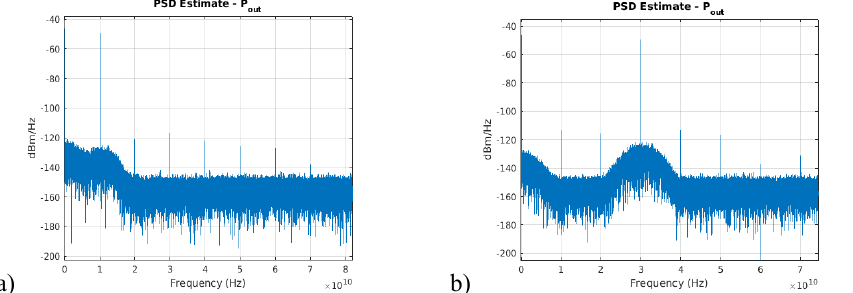
Fig. 4. Spectral density of the signal at the output of the photodetector: signal with frequency 10 GHz when two adjacent modes are separated from the comb (a) and signal with frequency 30 GHz when selecting from the comb two modes with a frequency difference of 30 GHz (b). The laser line width is 500 kHz, the laser power is 40 mW.